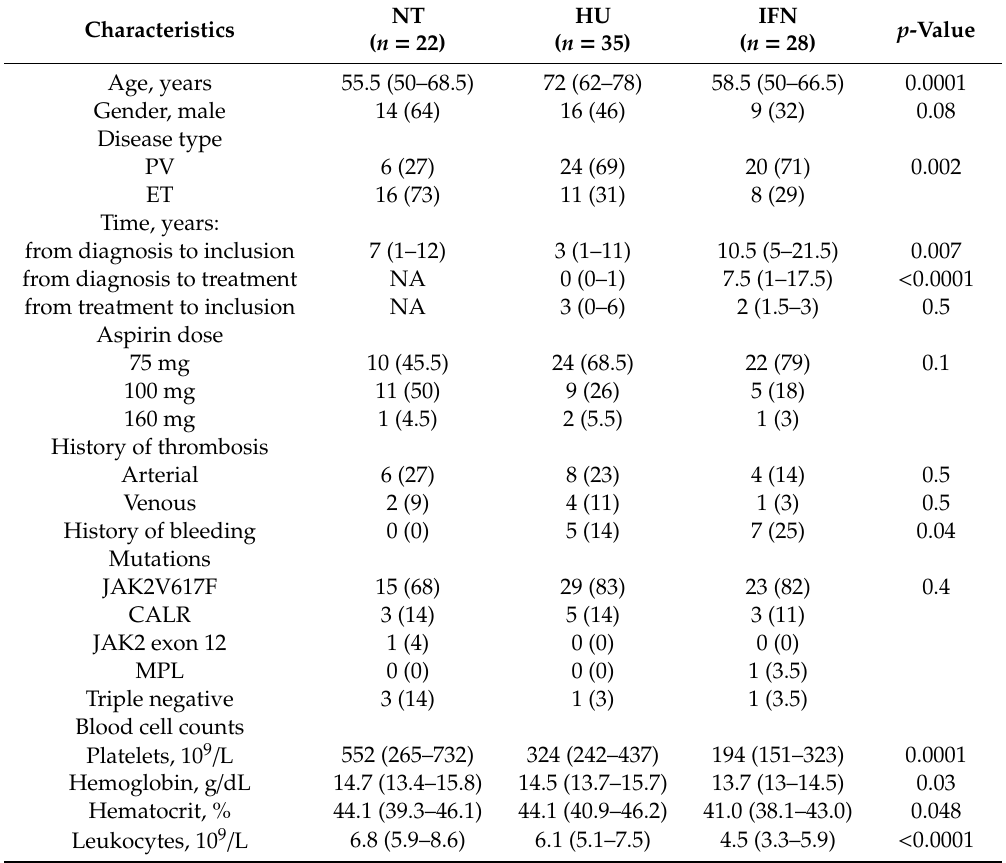
Table 1. Demographic, clinical, and biological characteristics of the study